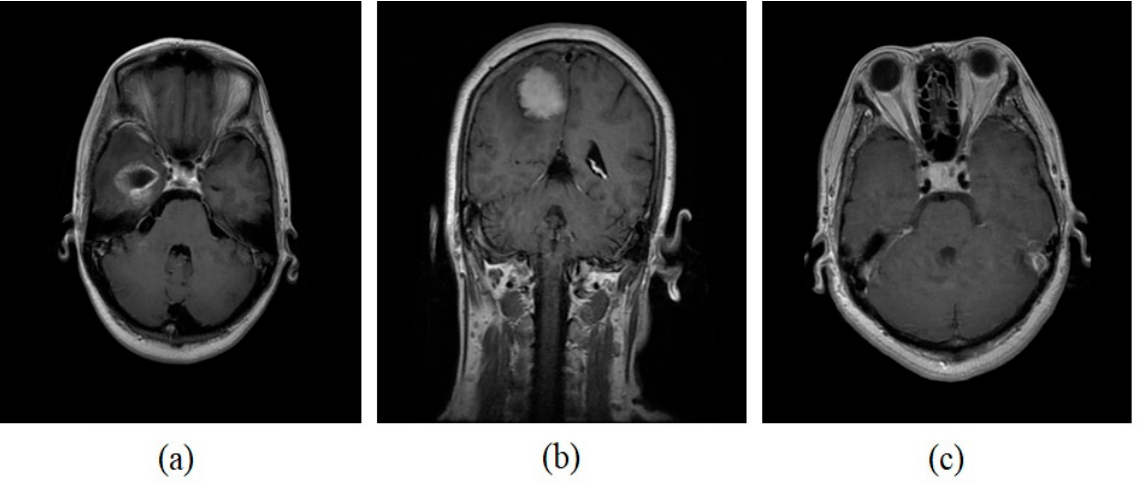
Figure 2. Sample brain tumor dataset from Figshare ( a ) Glioma ( b ) meningioma ( c ) pituitary.